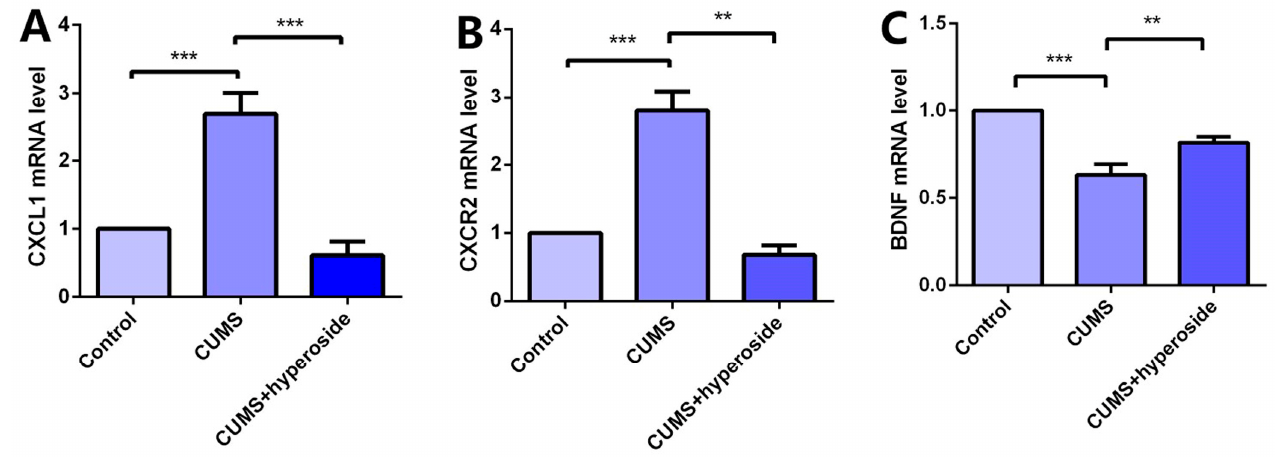
Figure 8. Hyp reduced CXCL1/CXCR2 mRNA levels and increased BDNF mRNA levels in the chronic-stress-induced mice. ( A ) Hyp reduced CXCL1 mRNA level expression in chronic-stress-induced mice. ( B ) Hyp reduced CXCR2 mRNA level expression in chronic-stress-induced mice. ( C ) Hyp prevents the downregulation of BDNF mRNA levels in chronic-stress-induced mice. Results are shown as the mean from multiple experiments, n = 5, one-way ANOVA, followed by Dunnett multiple comparison test; ** p < 0.01, and *** p < 0.001.